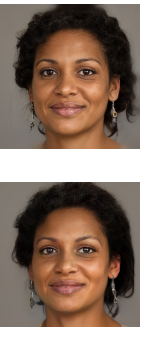
Figure 3. Examples of face images before (top row) and after (bottom row) the reconstruction using the inversion StyleGAN2 process available https://github.com/NVlabs/stylegan2-ada-pytorch/ blob/main/projector.py (accessed on 30 December